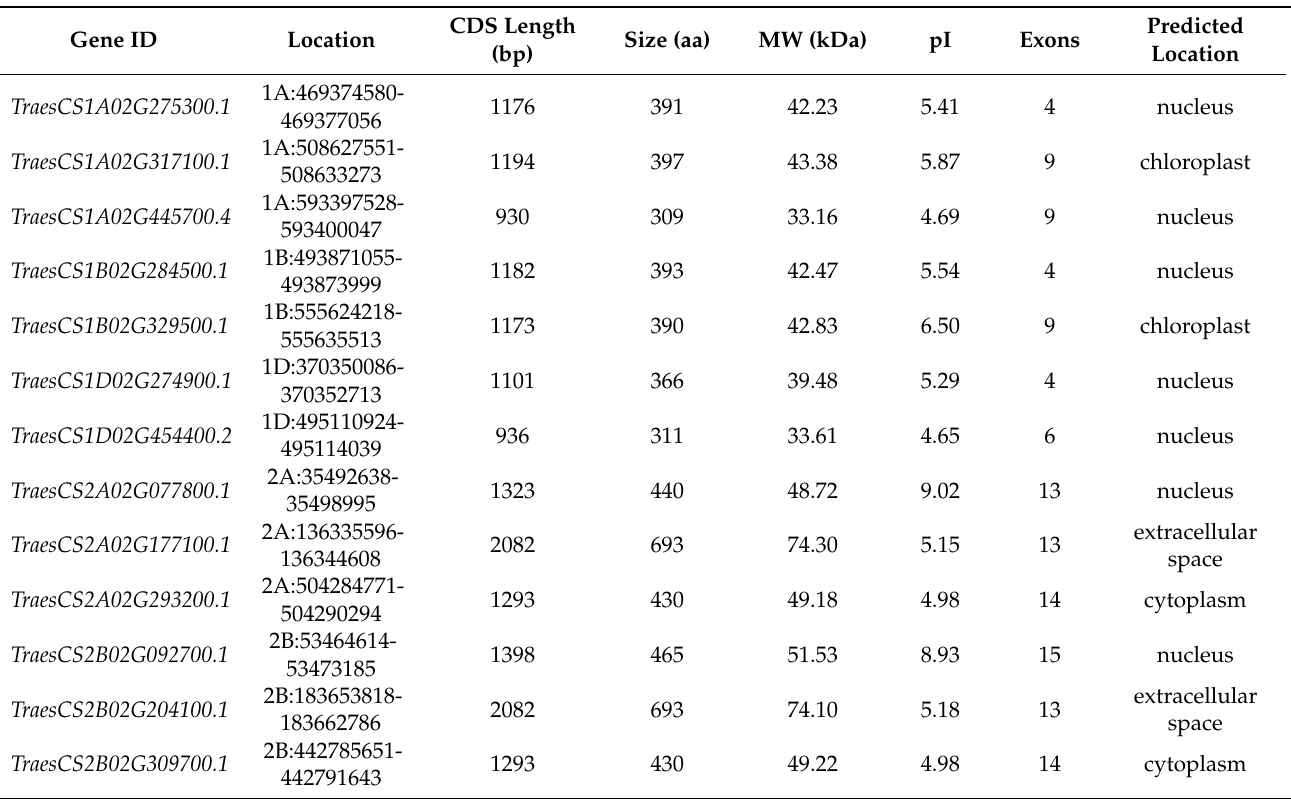
Table 1. Detailed information about 49 predicted HDACs in Triticum